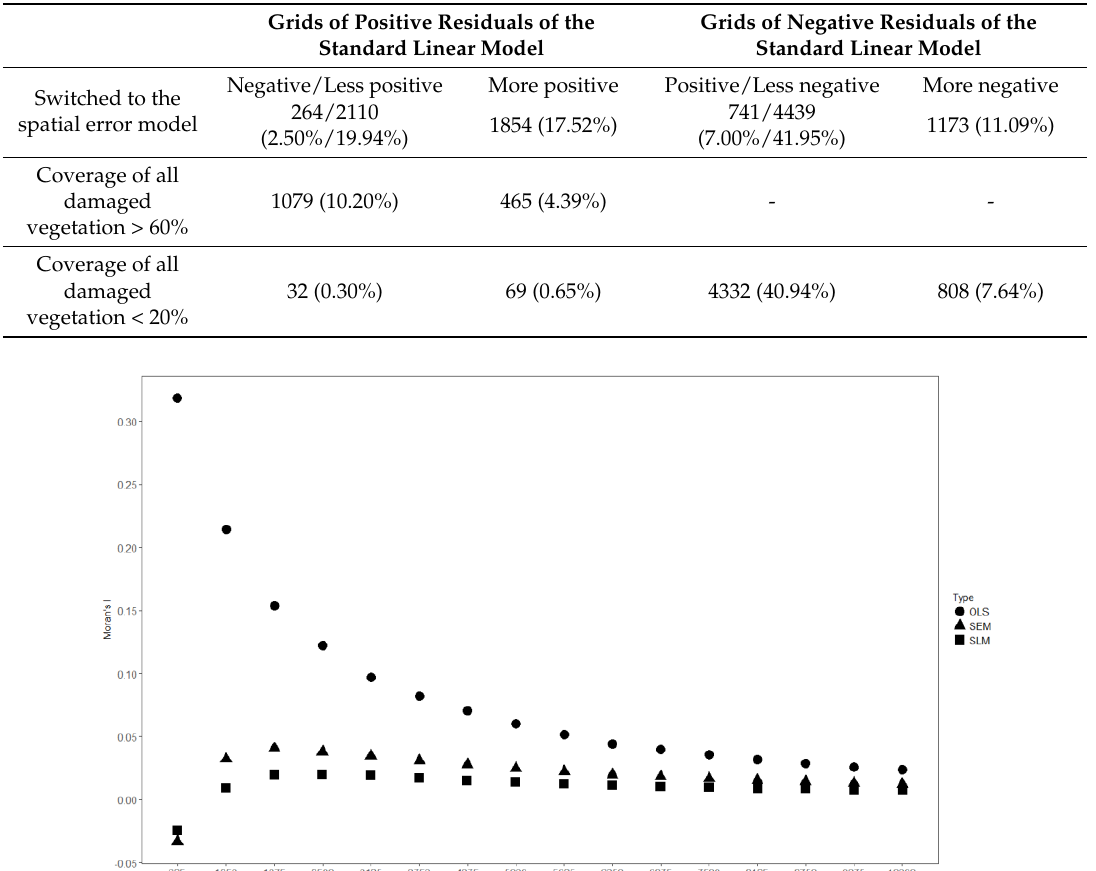
Table 9. A summary of the spatial error model for all vegetation types at four aggregation levels.